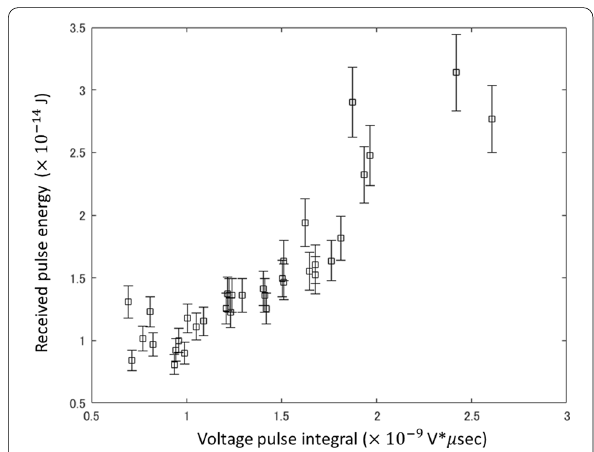
Fig. 7 S vrec and E obsrec for the 35 short rectangular pulses whose width is 10 ns